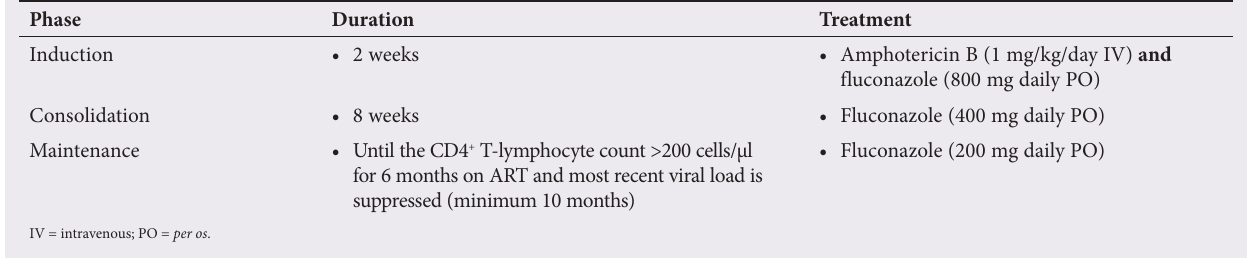
Table 3. Summary of recommendation 3: Management of first episode of CM Phase Duration Treatment